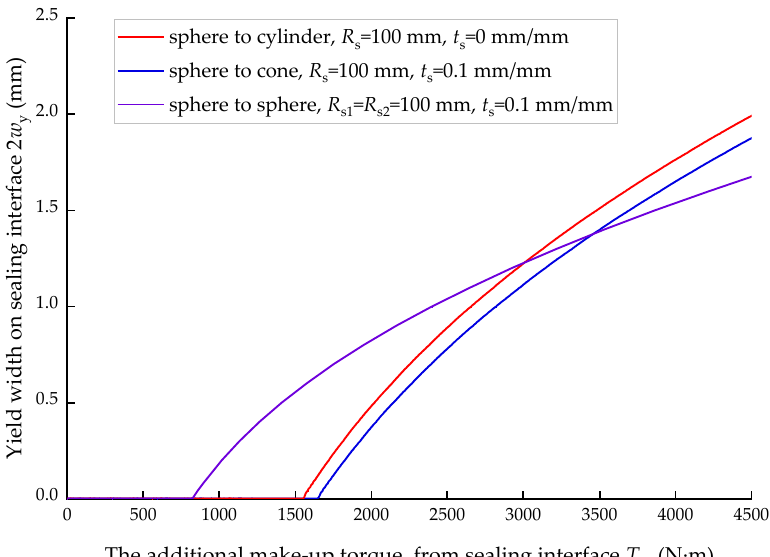
Figure 9. Effects of additional make-up torque from sealing interface on yield width on sealing interface for three kinds of sphere-type premium connections.